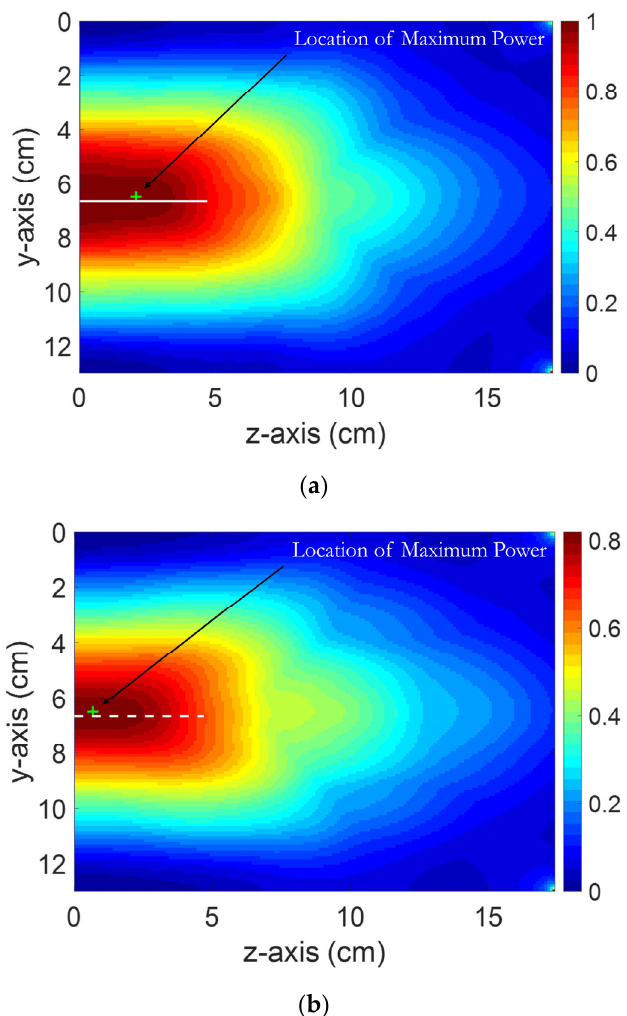
Figure 9. Distribution of the normalized maximum power over the calculation domain in absence of the source monopole antenna (mismatched media): ( a ) At cut plane x = 14.78 cm. The solid white line represents the location of the removed source monopole antenna. ( b ) At cut plane x = 16.78 cm. The white dashed line represents the projection of the removed source monopole antenna on the cut plane. The location of maximum power is shown using a green “+” sign.